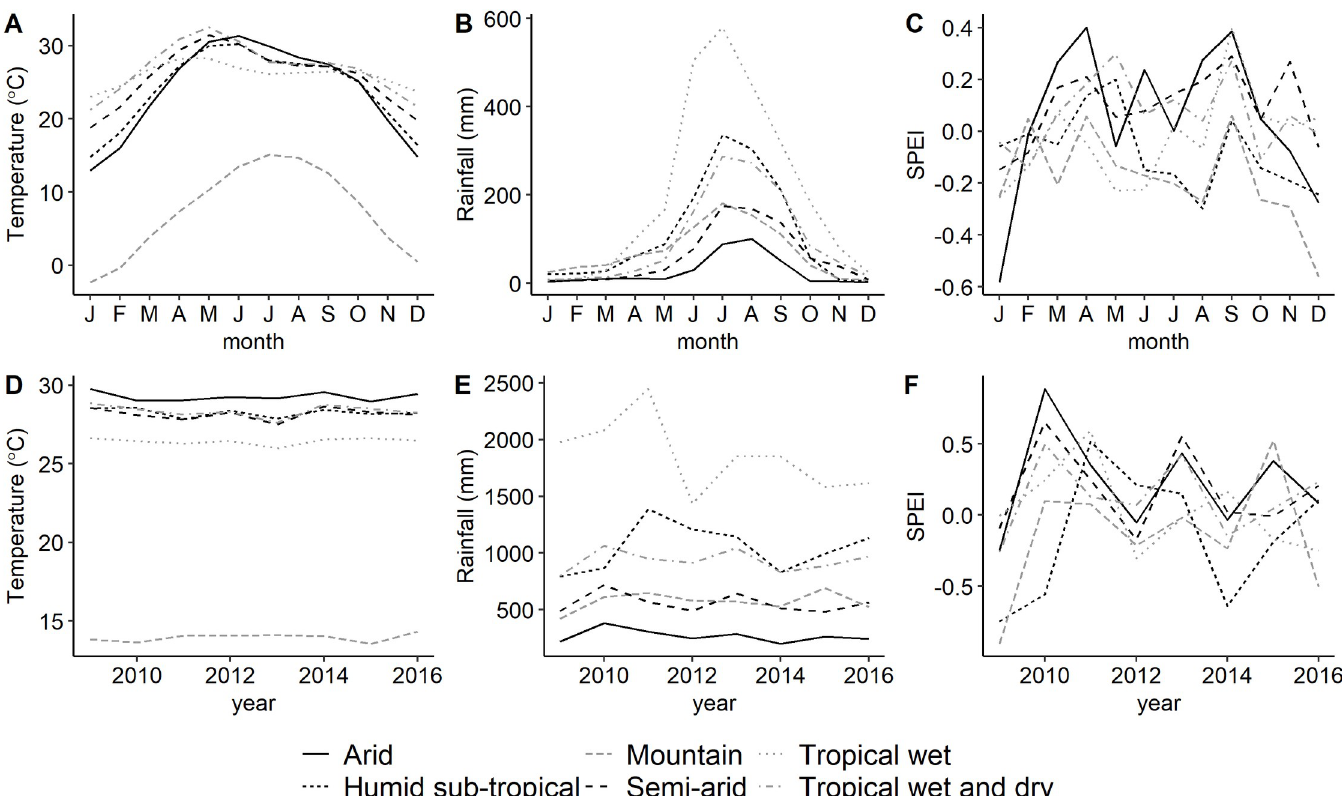
Fig 4. Monthly temperature (A), rainfall (B), and 1-month SPEI (C) by climate zone in India (2009–2016 average). Mean monsoon season temperature (D), total monsoon season precipitation (E), and mean monsoon season SPEI (F) by climate zone in India for the period 2009–2016. Source: Climatic Research Unit at the University of East Anglia (CRU TS 3.25).